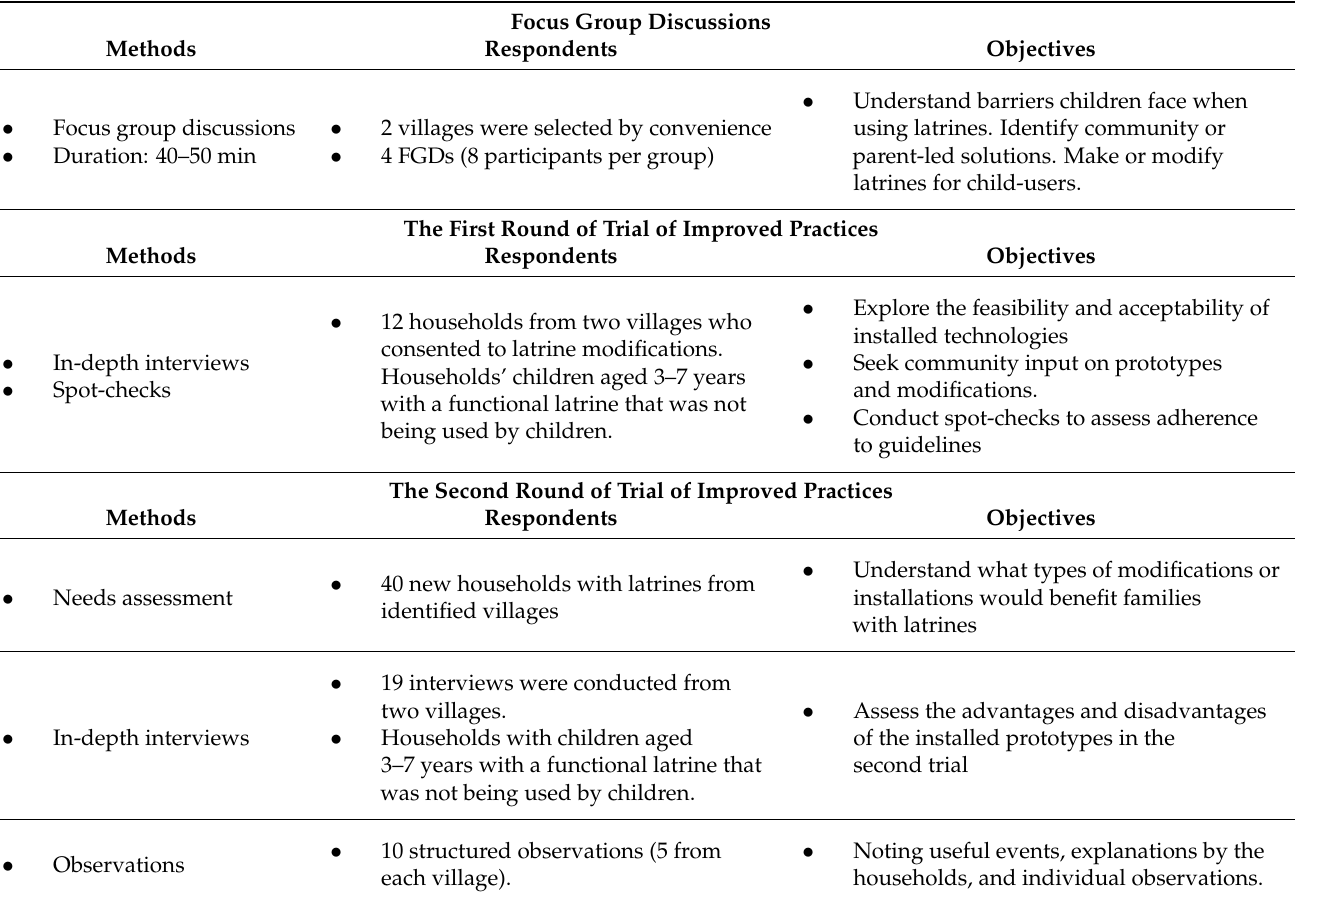
Table 1. Data collection